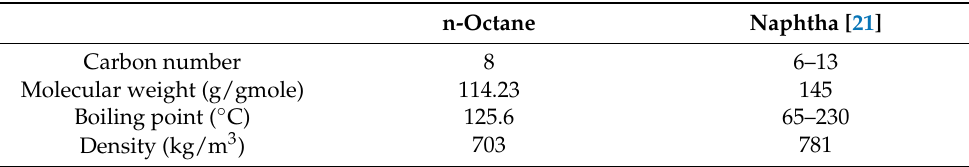
Table 1. Properties for n-Octane and